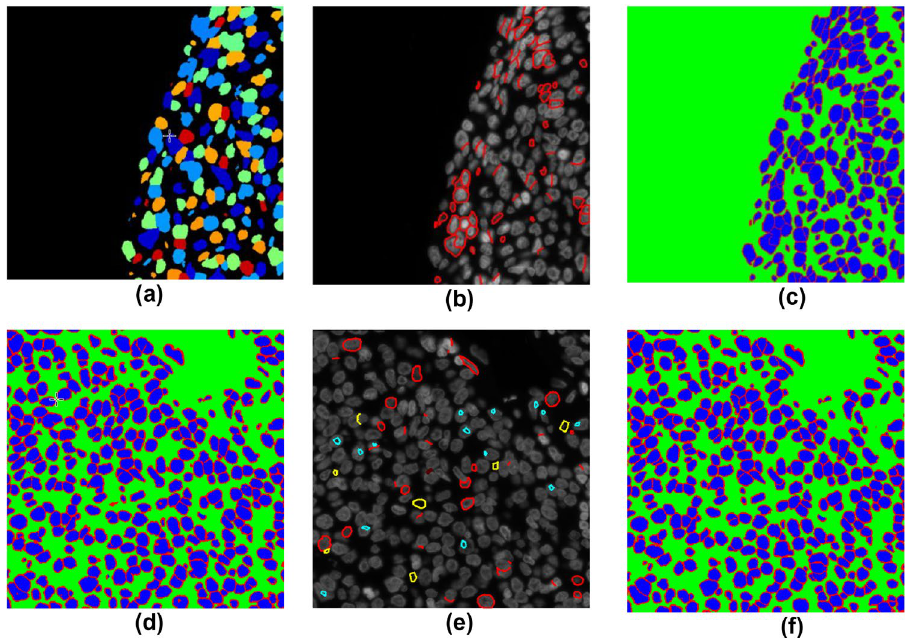
Figure 2. ROI samples (from weak-label-set ) for nucleus label generation using semi-automatic method. First row images ( a–c ) demonstrate nucleus label generation for the method using Cellprofiler + manual edits. ( a ) Label map generated using Cellprofiler. Different nuclei are labeled by different colors. ( b ) Manual edits that were performed on the DAPI channel image to correct the results in ( a ). Red annotations were added to segment the nuclei. ( c ) Label map generated from ( a ) and ( b ). Second row images ( d – f ) demonstrate generating nuclear labels using U-Net + manual edits. ( d ) Label map output from U-Net. ( e ) Manual edits were performed on the DAPI channel image to correct the results in ( d ). ( f ) Label map generated from ( d ) and ( e ). Color codes: In ( c ), ( d ), and ( f ) red—nuclear boundary, blue—interior of nucleus, and green—the background. In ( b ) and ( e ): red represents added lines as nuclear boundaries; yellow contours the nuclear boundaries for removal; cyan contours the nuclei for removal.